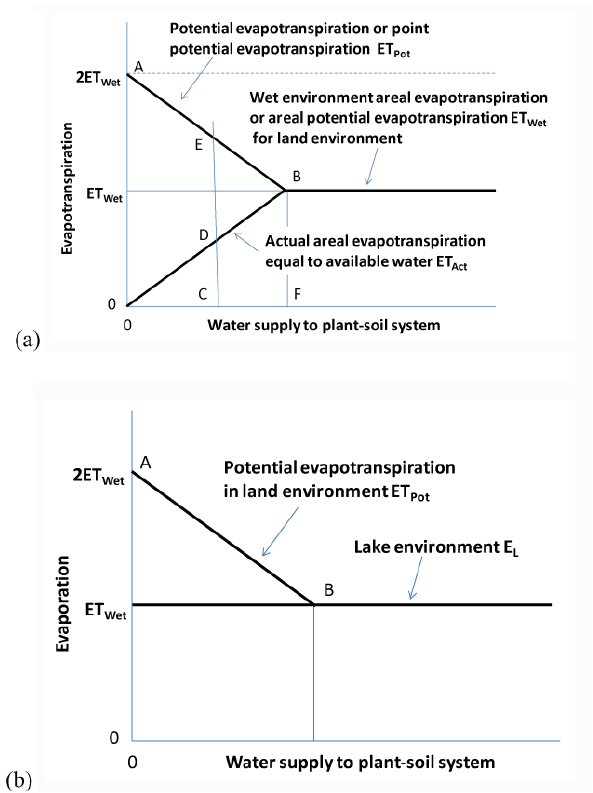
Fig. 2. Theoretical form of the complementary relationship for: (a) land environment and (b) lake environment (adapted from Mor- ton, 1983a, Figs. 5 and 6). In Fig. 2a, at point B and beyond where there is adequate water supply (saturated soil moisture), actual evap- otranspiration equals areal potential evapotranspiration. As the wa- ter supply reduces below B, evaporative energy not used in ac- tual evapotranspiration remains as potential evapotranspiration as required by the complementary relationship (i.e. ET Act =2ET Wet - ET Pot ).